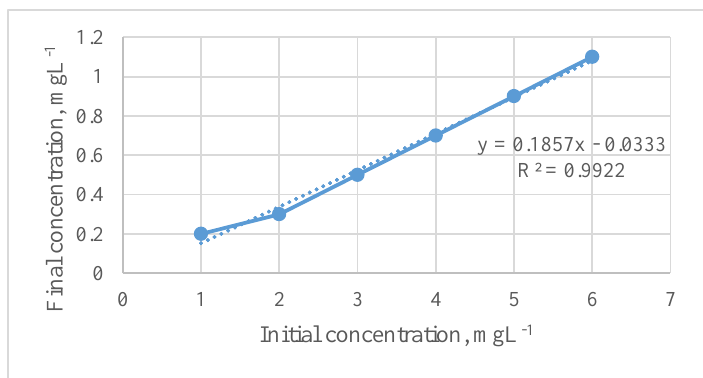
Figure 7. The method calibration curve for PO 43 − using the CA/GO/SDS membrane.